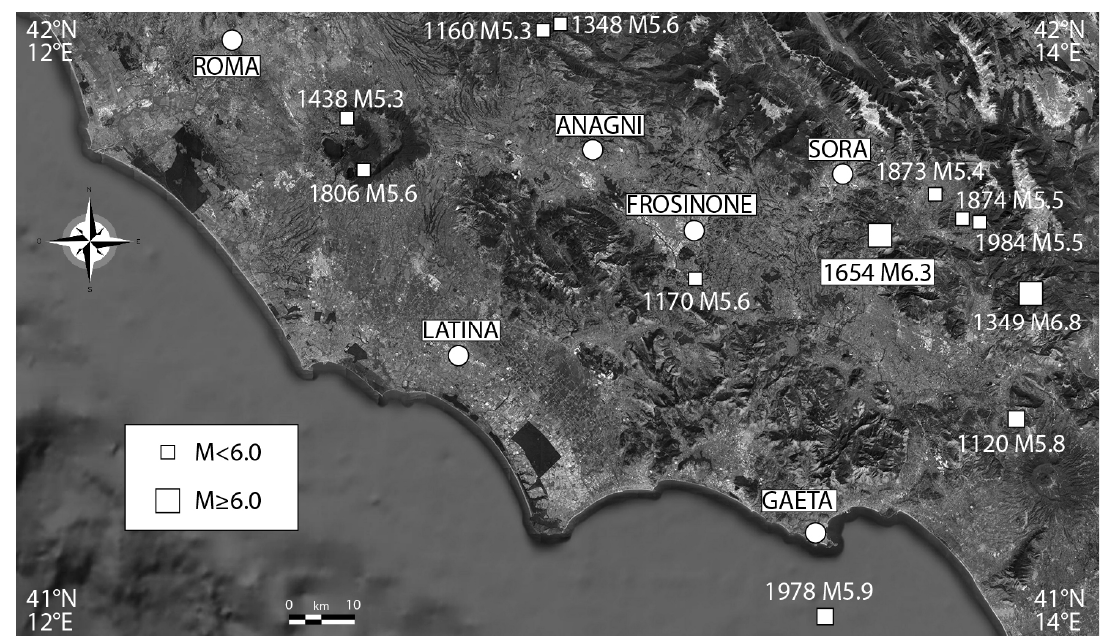
Figure 3. Historical seismicity [5] of the southern Lazio region. The 1654 earthquake is the strongest event to have occurred in this area, apart from the 1349 event.